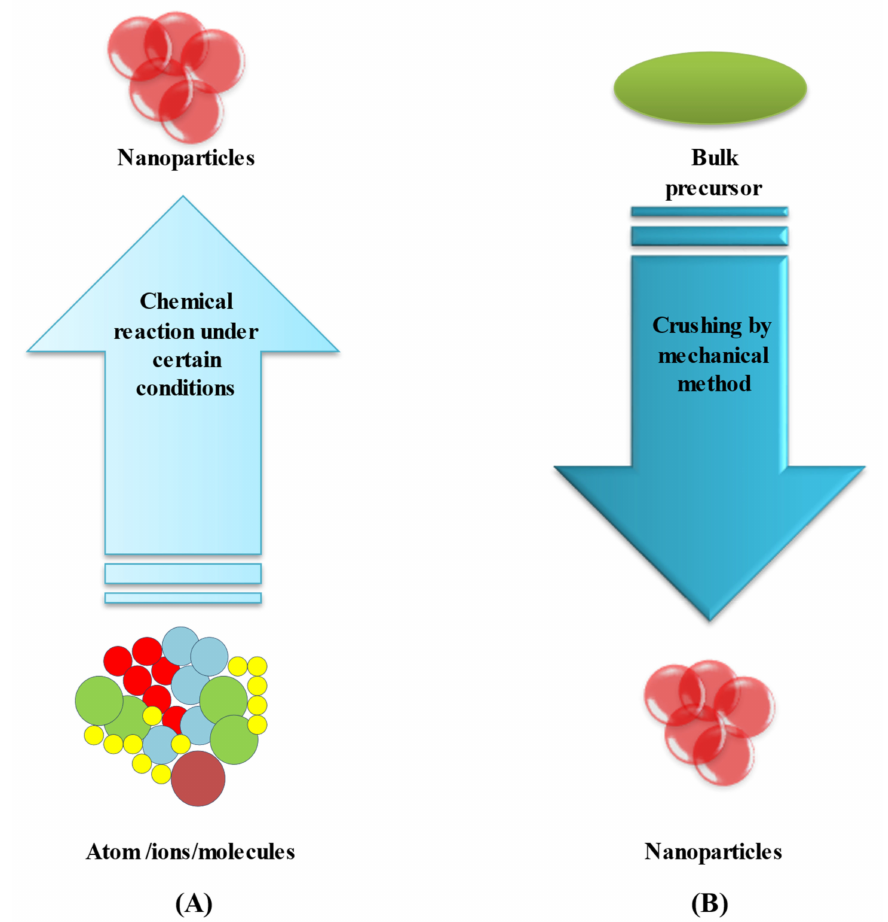
Figure 3. Synthesis methods of nanoparticles: ( A ) bottom-up, ( B ) top-down